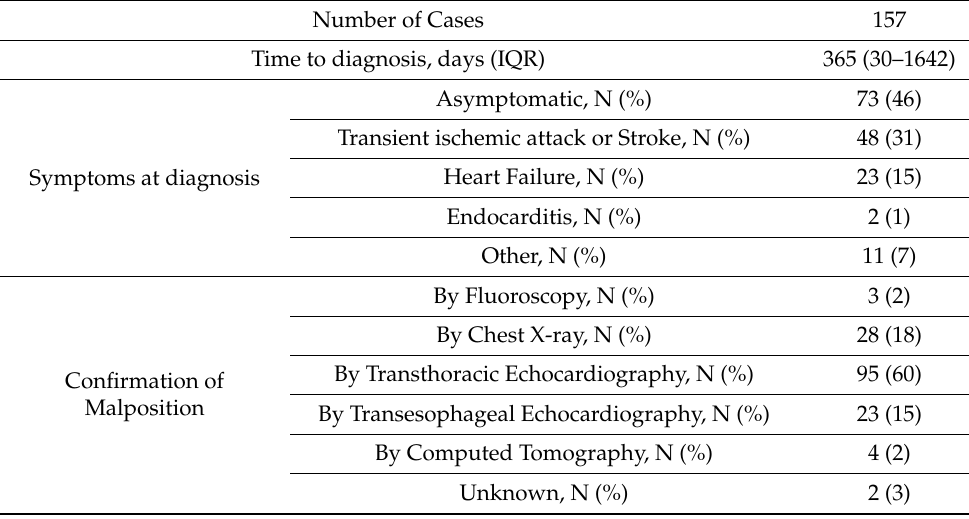
Table 2. Diagnosis of inadvertent lead malposition in the left heart